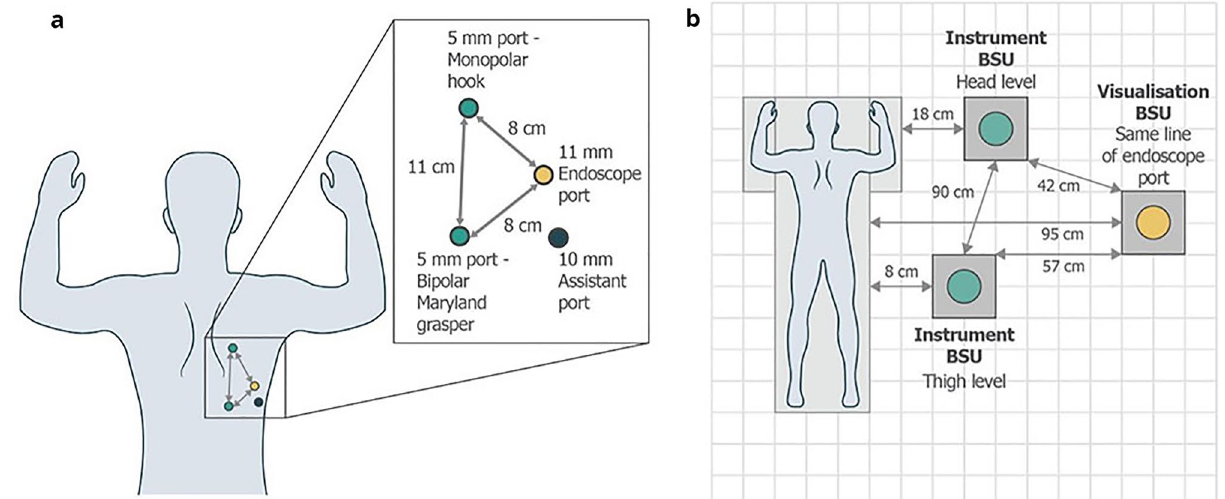
Figure 2. Port positioning and operating room layout. Port positioning for TTE ( a ) with corresponding BSU positions ( b ). An 11 mm endoscope port was placed in the 5th or 6th intercostal space. The right 5 mm instrument port was placed approximately in the 3rd intercostal space. The left 5 mm instrument port was placed in the 7th–8th intercostal space. One 10 mm assistant port was placed between the left instrument port and the endoscope port. BSU bedside unit, TTE transthoracic